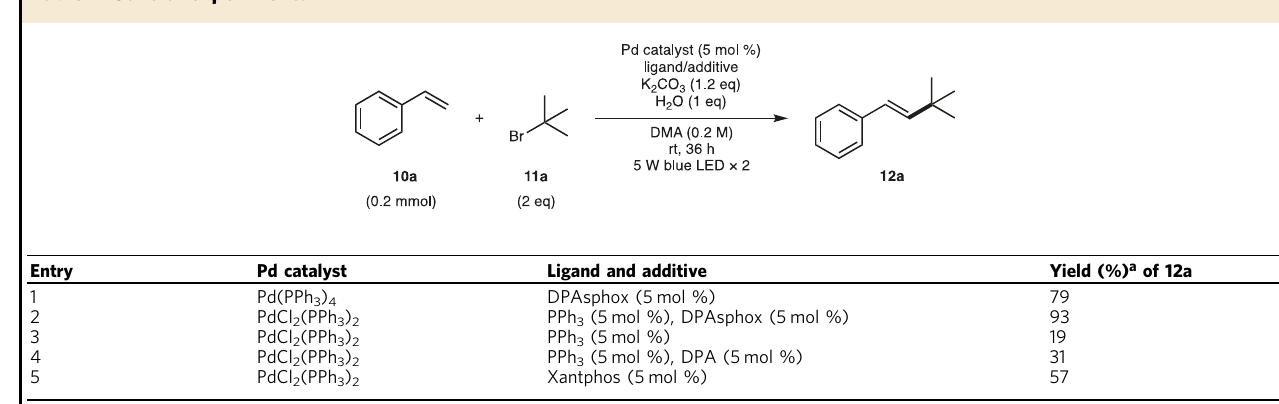
Table 2 Control experiments.